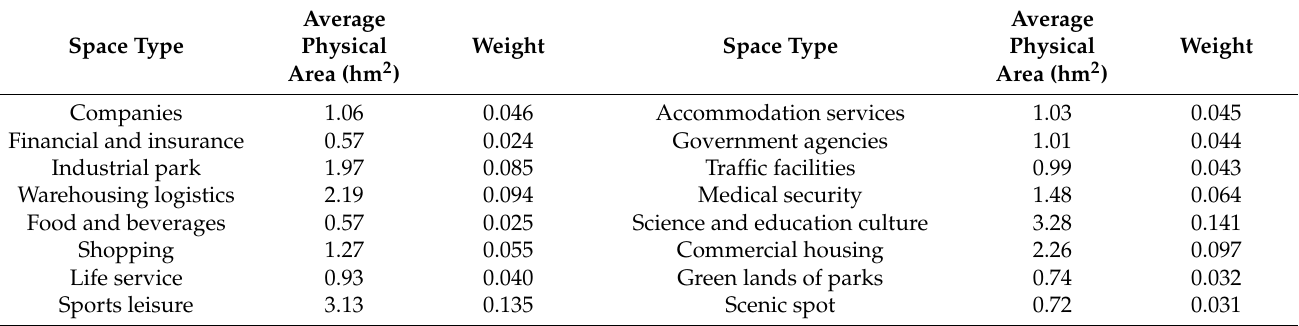
Table 2. The area-based weight of each POI